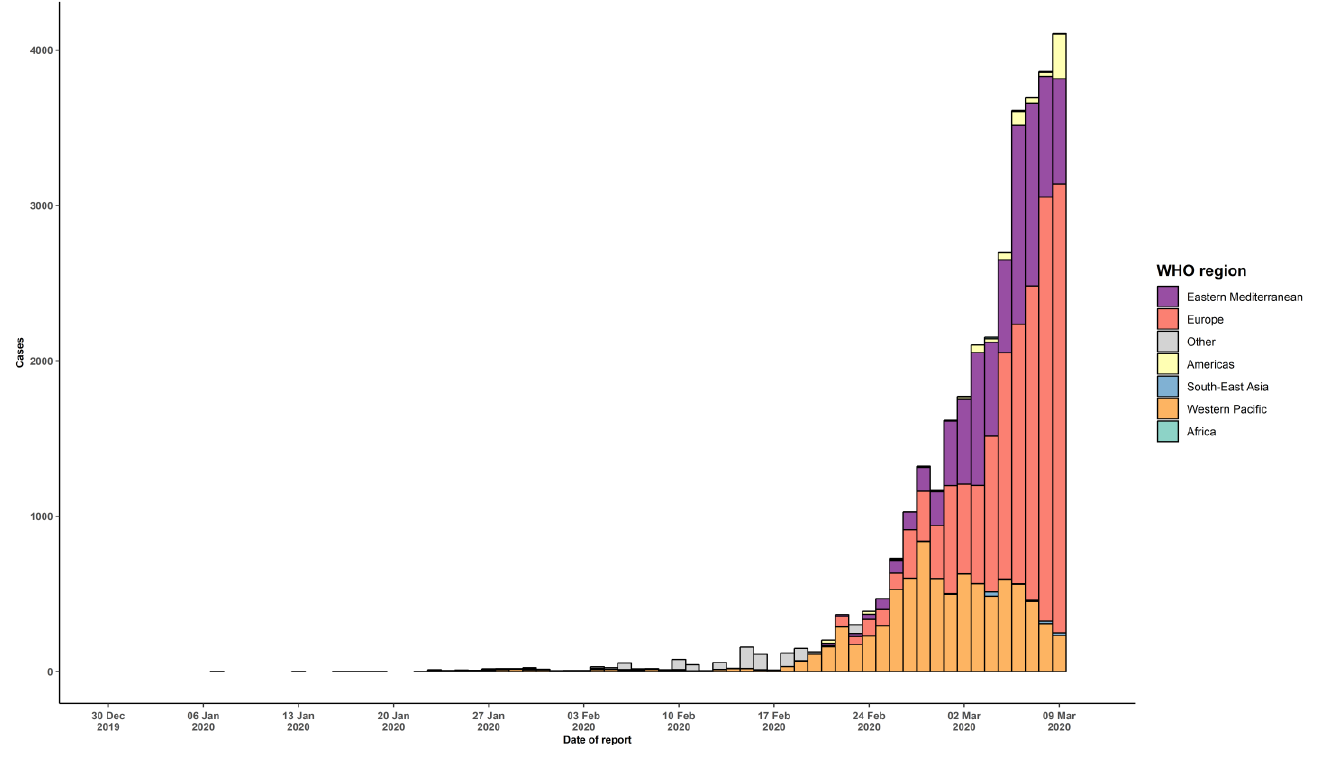
Figure 2. Epidemic curve of confirmed COVID-19 cases reported outside of China ( n =32 778), by date of report